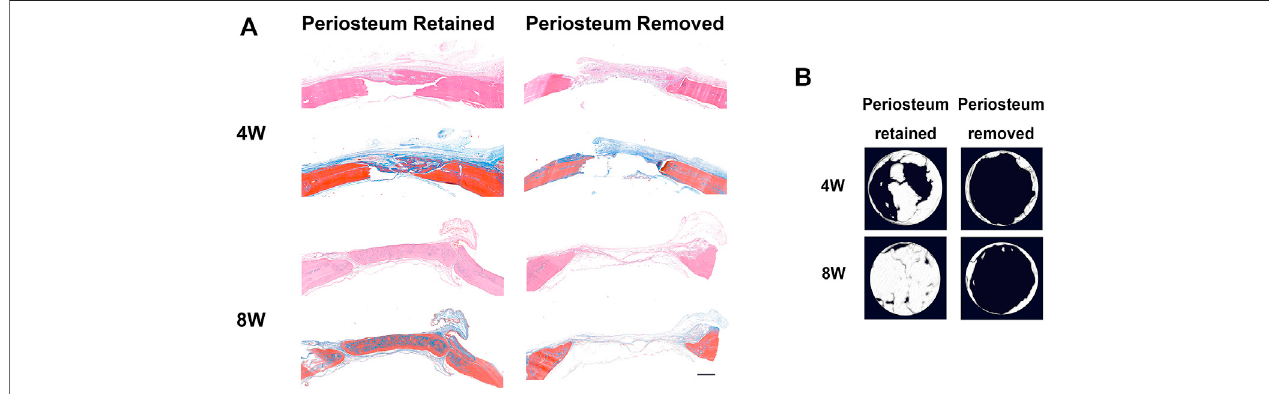
FIGURE 1 | The periosteum is indispensable in rat calvarial bone regeneration. (A) HE and Masson staining of defected calvarial bone, with periosteum above the defect region retained or removed, 4 and 8 weeks after surgery (scar bar: 500 μ m). (B) The micro-CT results for calvarial bone regeneration.